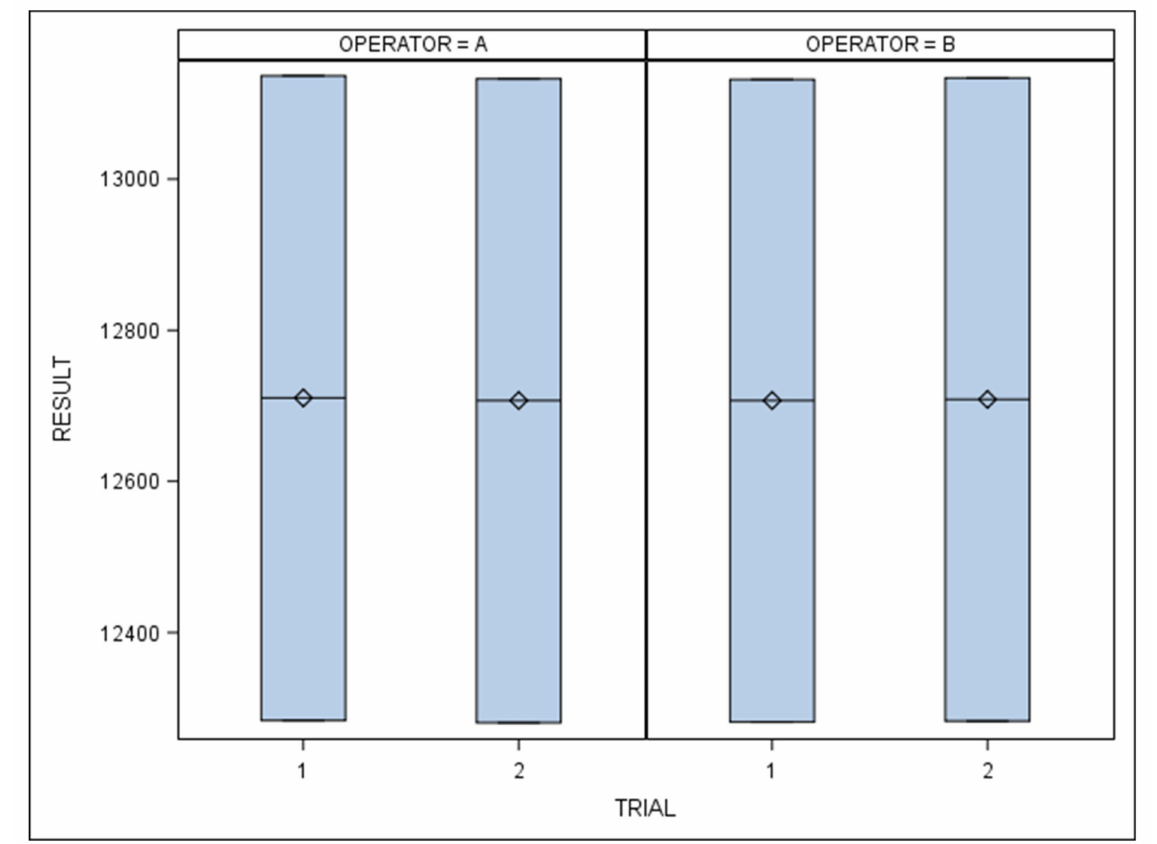
Figure 5. Box plots of results obtained by each operator in each trial. The horizontal lines represent each box’s respective median